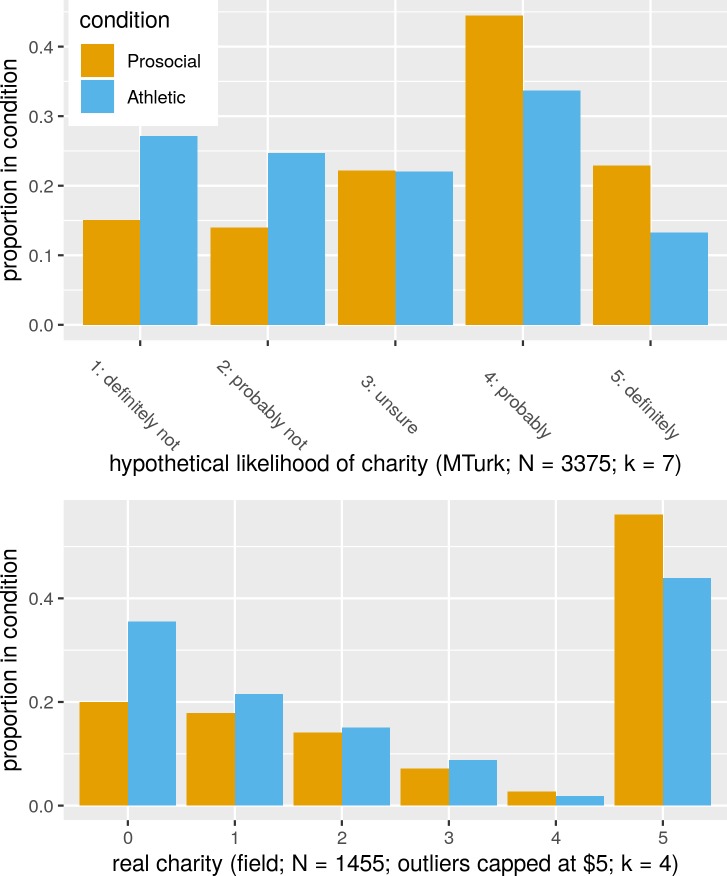
Prosocial contagion: Exposure to a prosocial video is associated with more charitable behavior and intent than exposure to a similarly entertaining control video.Figure pools data from all studies contrasting similar conditions (K = 11).